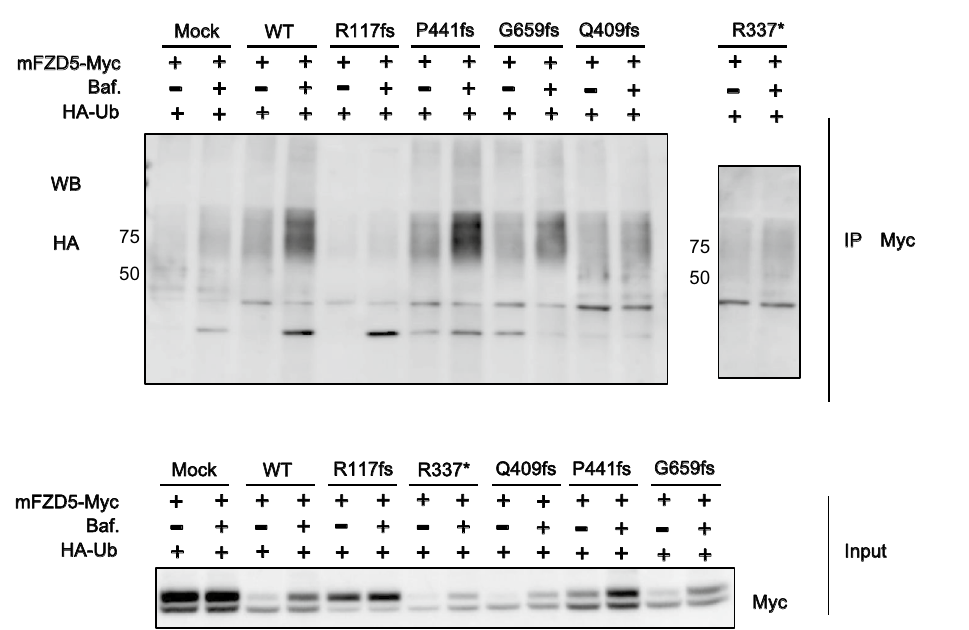
Figure 6. The RING domain of RNF43 is required for RNF43-mediated FZD5 ubiquitination. HEK293T cells were transfected with Myc-FZD5, FLAG-RNF43, or HA-ubiquitin as indicated. R117fs mutant, which does not contain the RING domain, suppressed the ubiquitination of FZD5. WT and mutant RNF43 increased the ubiquitination of